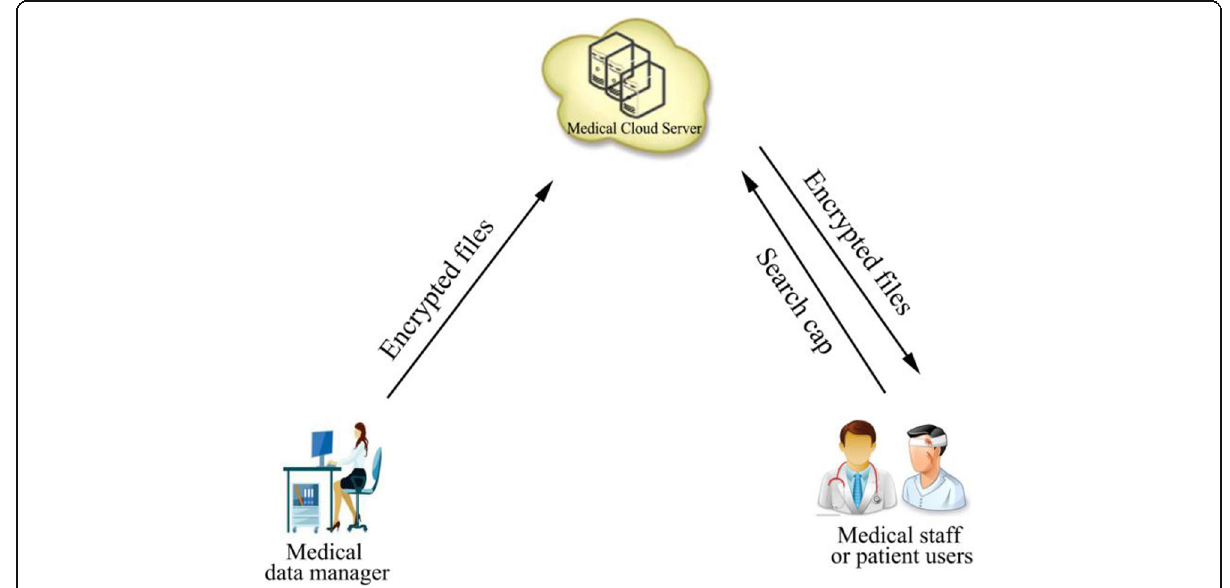
Fig. 1 Users generate search credentials